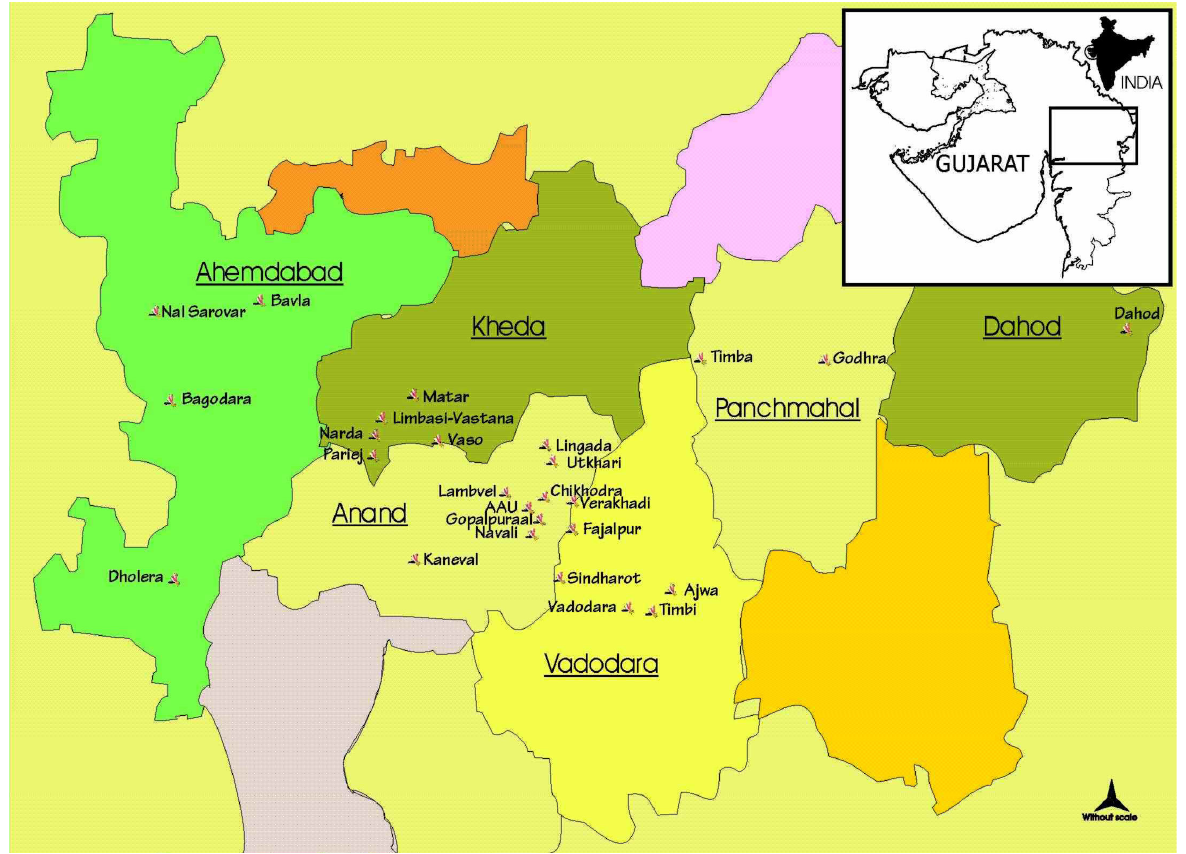
Figure 1. Study area showing six districts of central Gujarat and collection